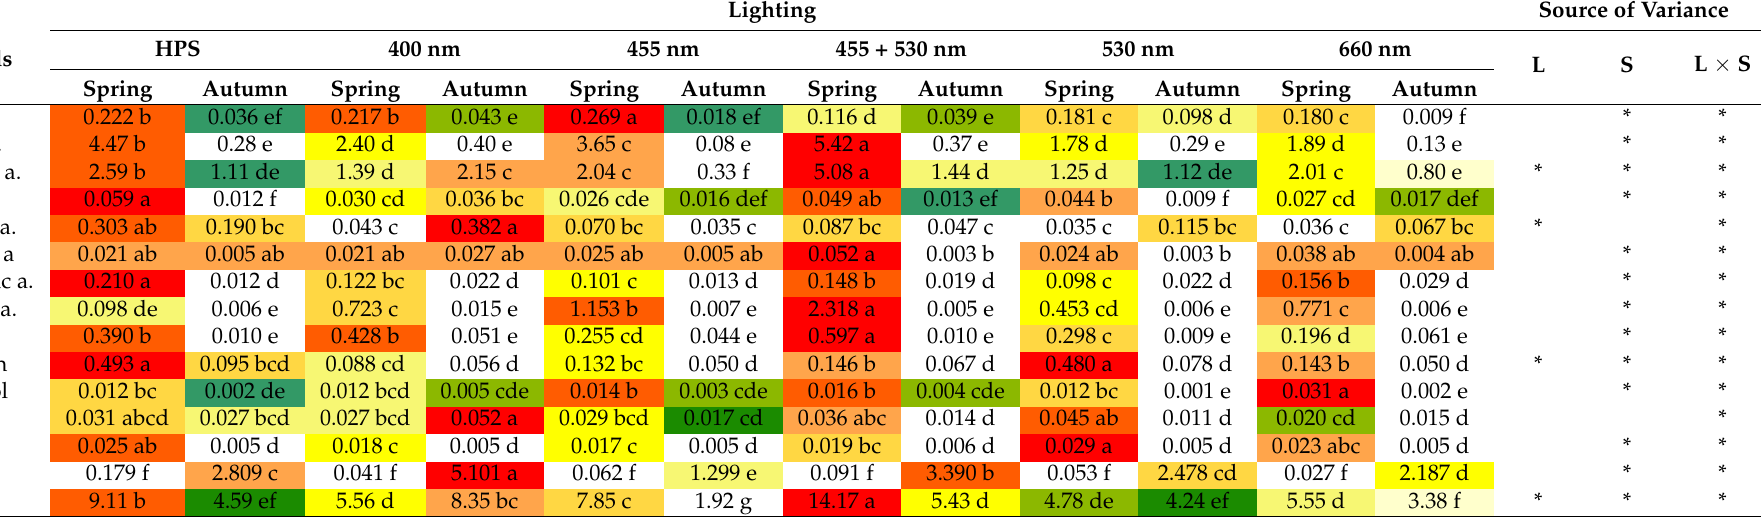
Lighting Source of Variance